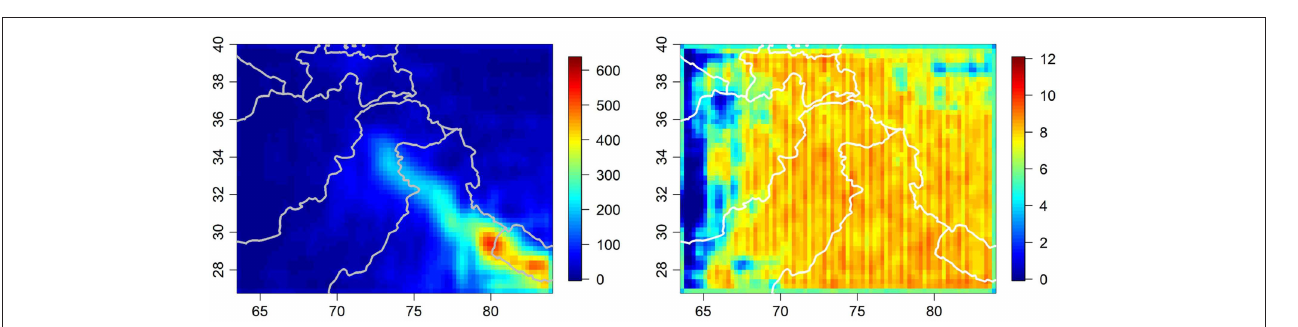
FIGURE 4 | Shared precipitation surface (in mm) for August 2000 on left. Corresponding uncertainty surface on right. Uncertainty characterized using posterior mean standard deviation (in